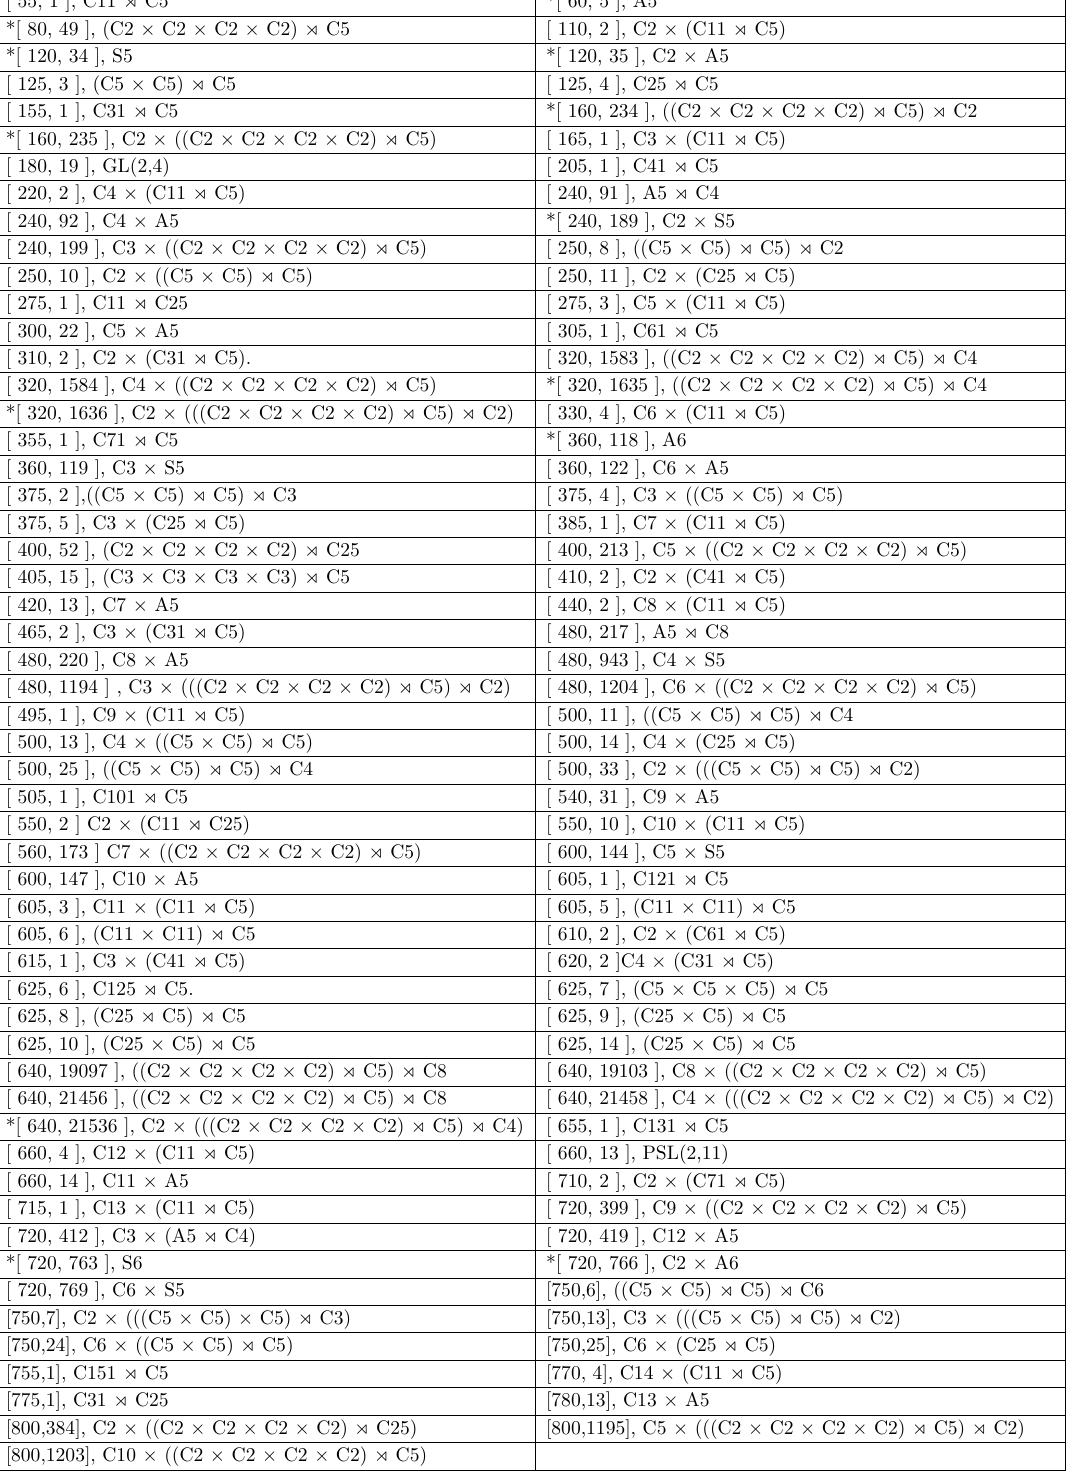
Table 5 . Finite subgroups of U(5) of order up to 800 with faithful 5-dimensional irreducible representations. Groups marked with “*” are also subgroups of O(5). The two integers [p,q] denote their id in Small Groups library, and p is the order of the finite